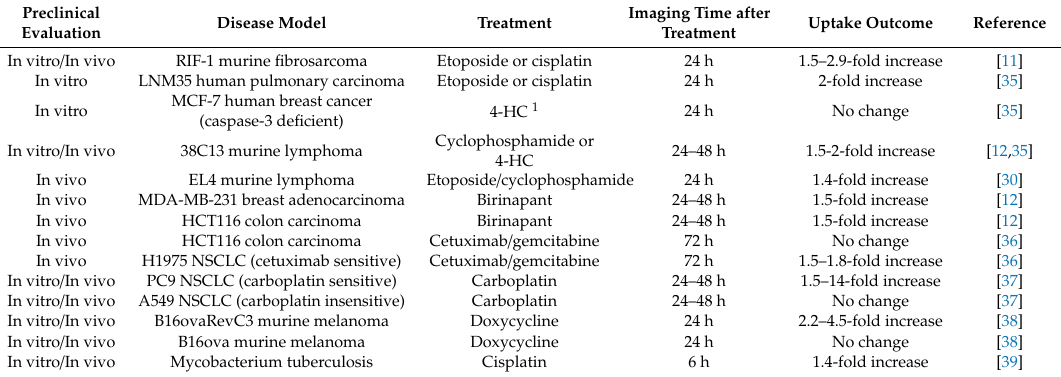
Table 2. Results of the preclinical evaluation of [ 18 F]ICMT-11 in treated tumours. Preclinical